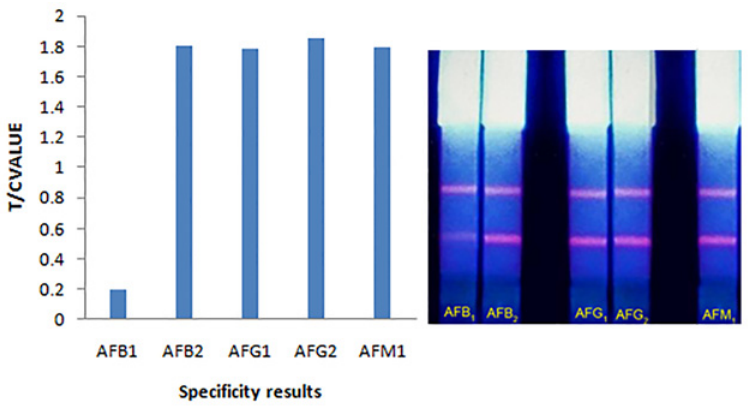
Fig 4. Cross-reactivities of AFB 1 CTRFIA strip with AFB 2 , G 1 , G 2 and M 1 at the concentration of 20